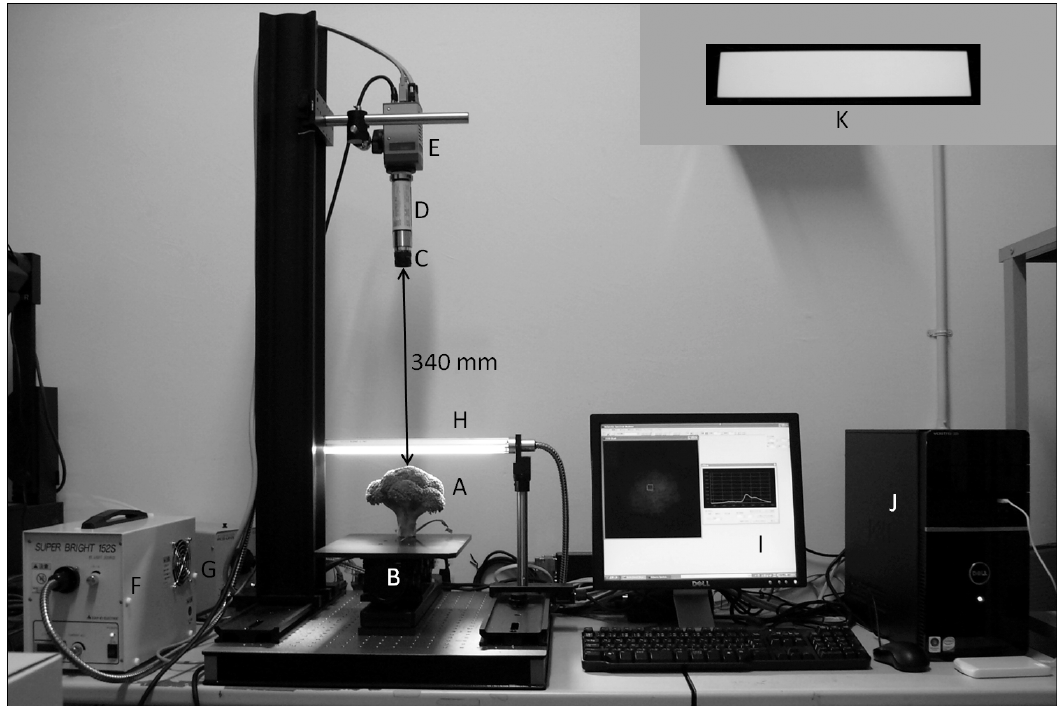
Figure 1. Overall view and description of the components in the hyperspectral camera system